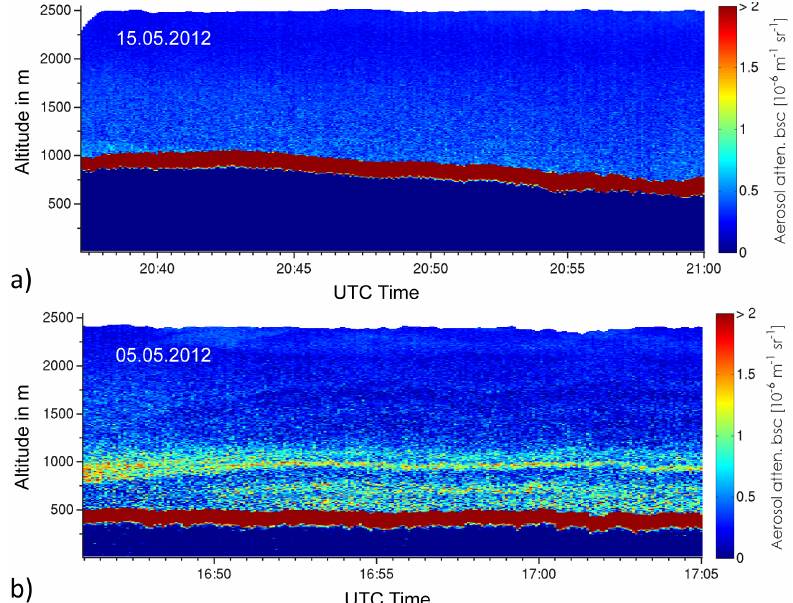
Figure 6. (a) AMALi Lidar backscatter signal from the studied boundary cloud layer in comparison with measurements including a thick aerosol layer above a cloud layer (b)